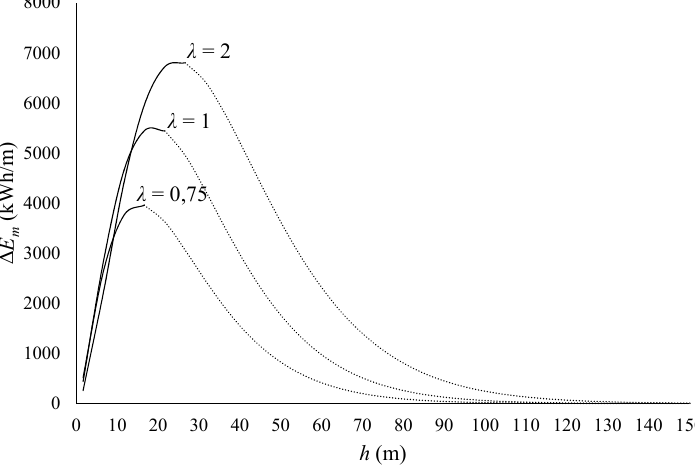
Figure 2. Theoretical trend of average missed energy above a given threshold h in the EPSs with maximum H s greater than h .